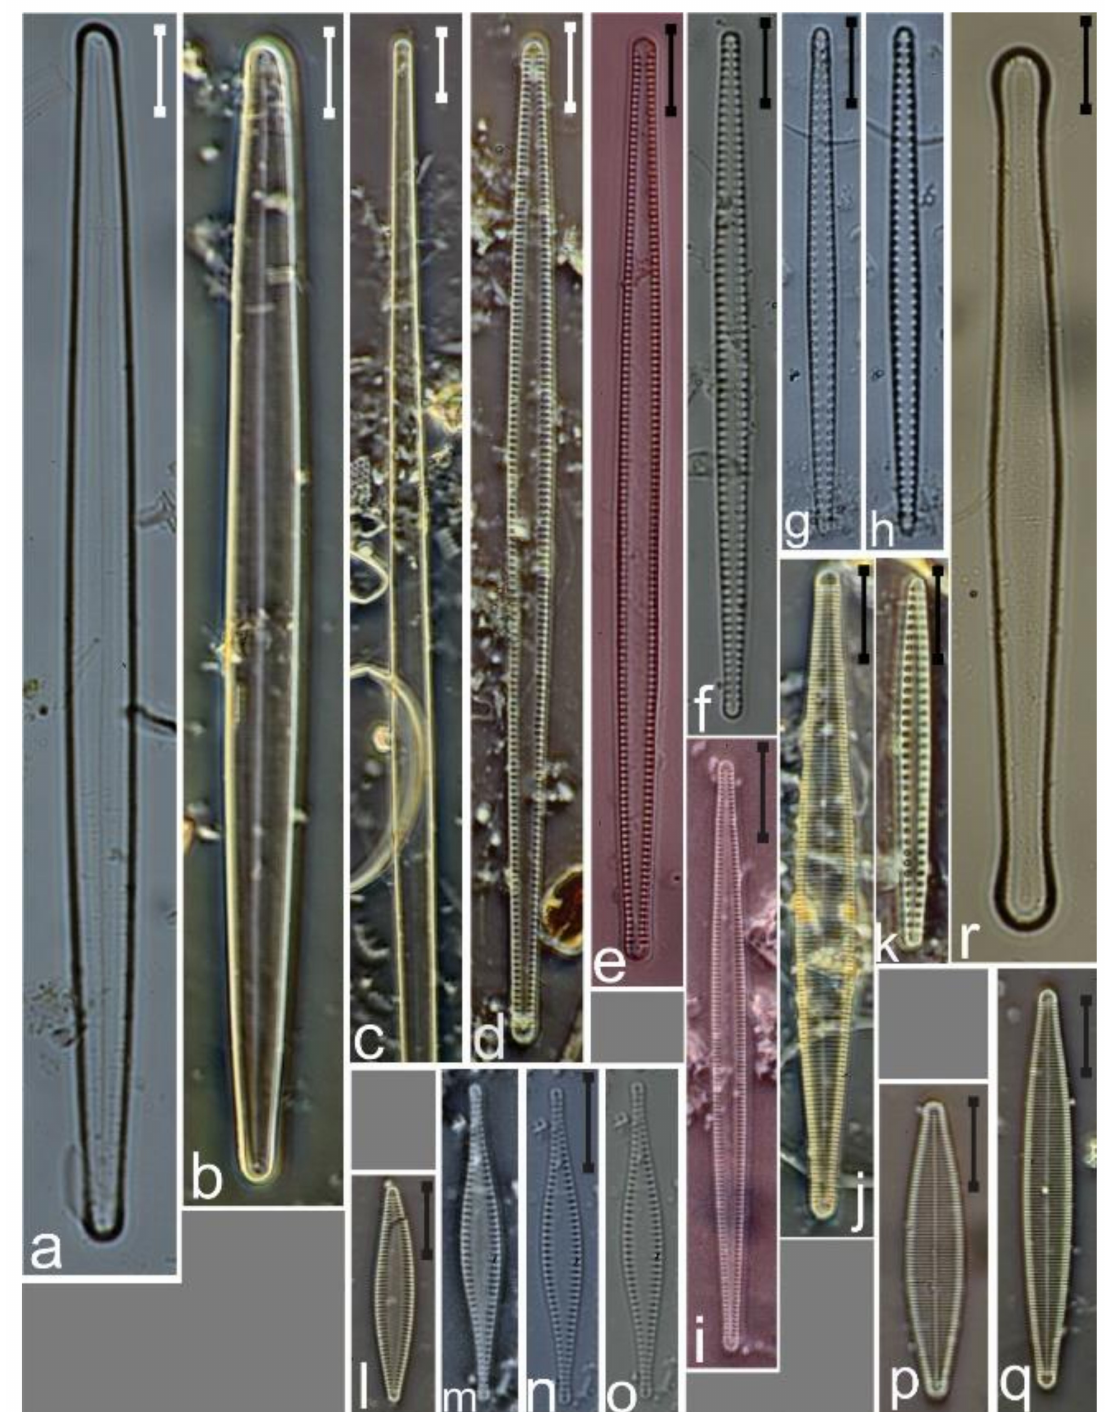
Figure 20. ( a , b ) Synedra gaillonii var. macilenta cf.; ( c ) Hyalosynedra laevigata ; ( d – f ) Tabularia tabulata ; ( g , h , k ) T. investiens ; ( i ) T. parva ; ( j , p , q ) Fragilaria barbatula ; ( l ) Tabularia fasciculata ; ( m – o ) Synedra tabulata var. rostrata ; ( r ) Grammatophora macilenta . Scale bar = 10 µ